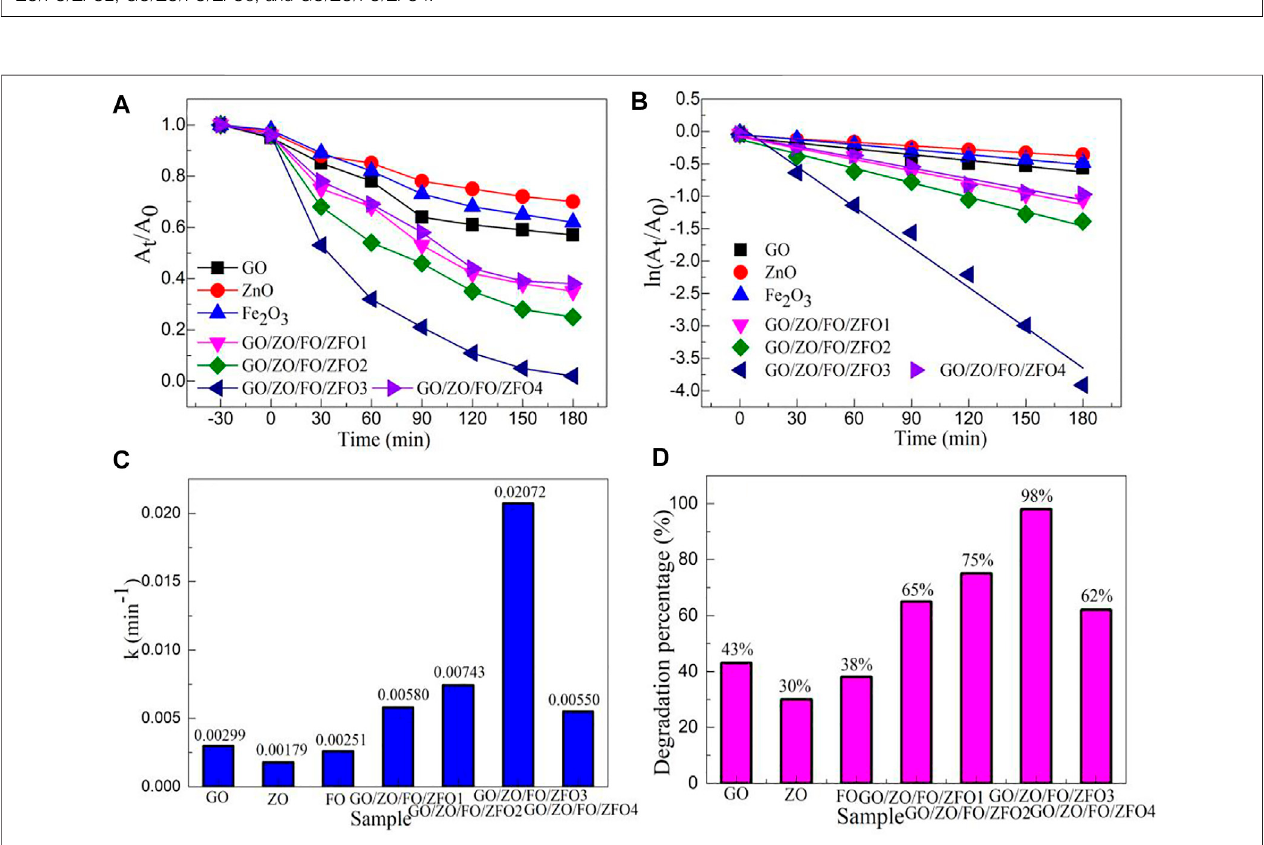
FIGURE 7 | (A) Time-dependent characteristic, (B) plots of ln (A t /A 0 ) vs. irradiation time (t), (C) fi rst-order kinetic constant (k), and (D) degradation percentage of degradation of methyl orange in the presence of samples GO, ZnO, Fe 2 O 3 , and GO/ZO/FO/ZFO under simulated solar irradiation.